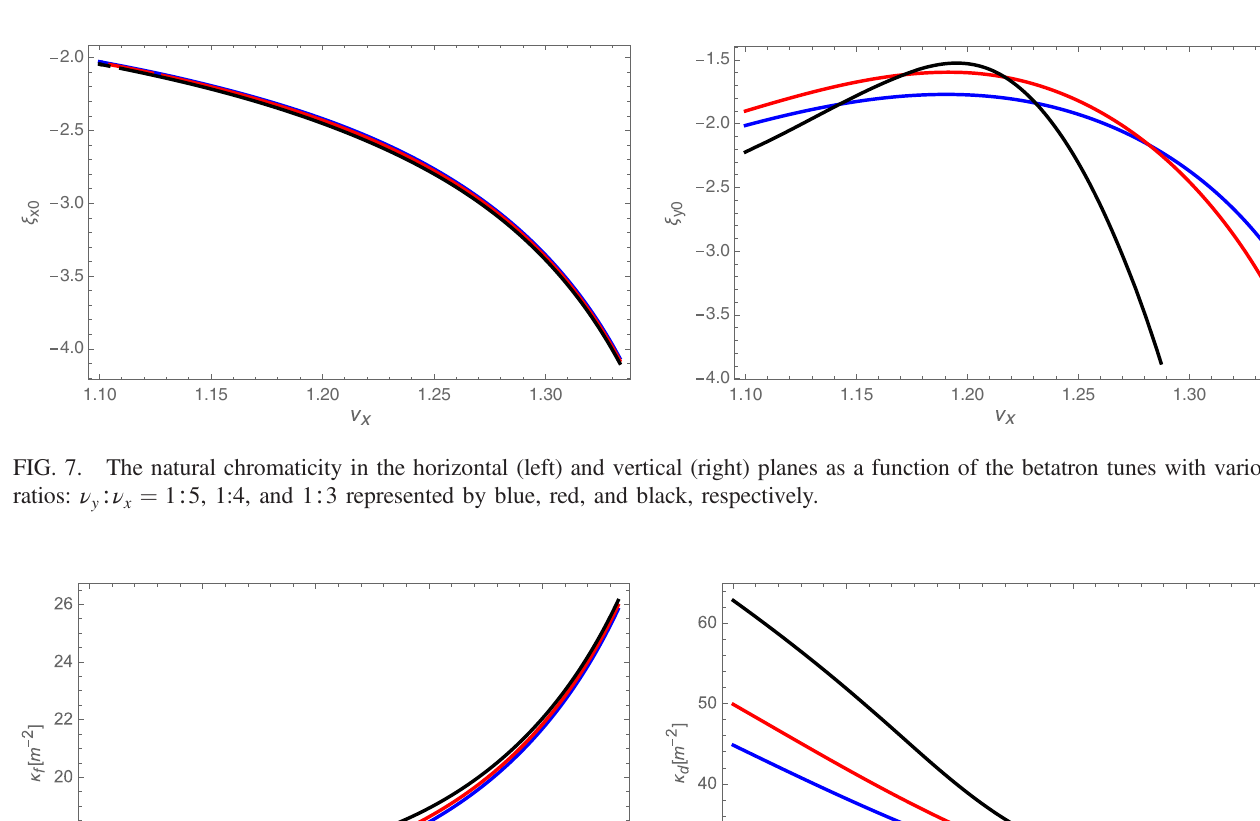
FIG. 8. The settings of focusing (left) and defocusing (right) sextupoles as a function of the betatron tunes with various ratios: ν 1 ∶ 5 , 1:4, and 1 ∶ 3 represented by blue, red, and black,